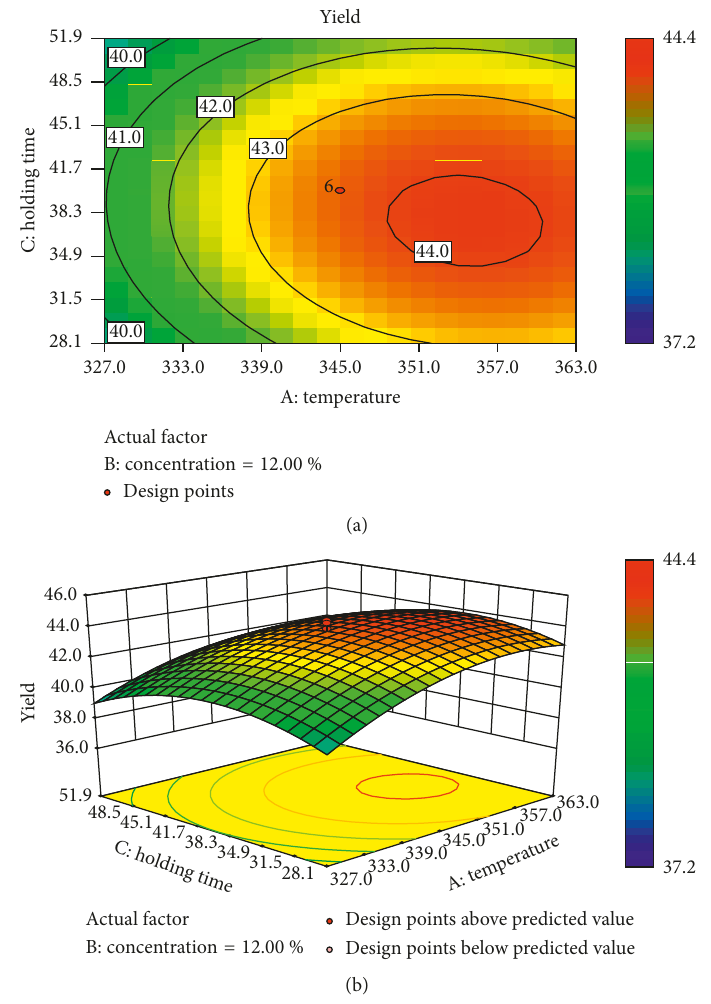
Figure 4: Contour plot and response surface plot of biocrude yield as function of temperature and holding